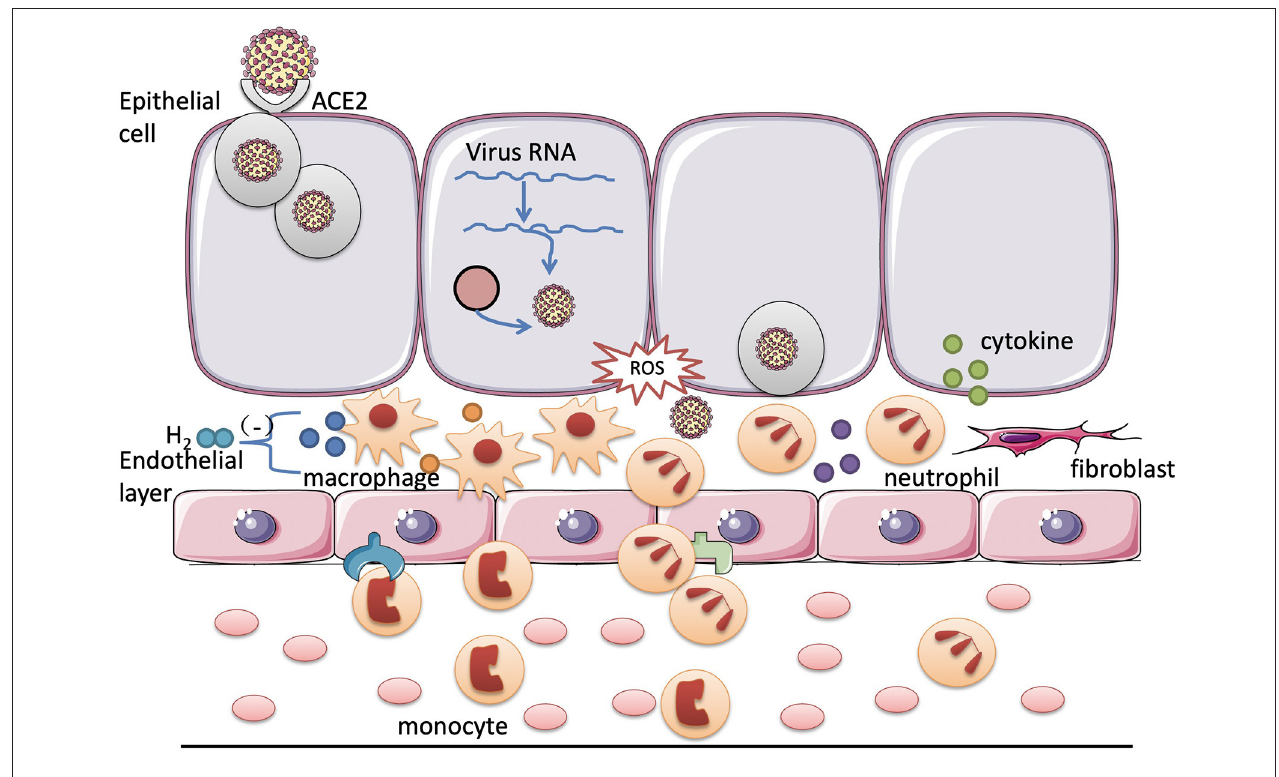
FIGURE 1 | Potential targets of hydrogen for the treatment of the coronavirus disease 2019 (COVID-19). After the viral infection, the inflammatory cells in the tissues and blood are activated to destroy the virus through phagocytosis and the release of cytokines. However, excessive inflammation causes uncontrollable body damage. In the COVID-19, hydrogen may exert its protective effect on the respiratory system by inhibiting the excessive activation of the neutrophils and macrophages and reducing the release of the cytokines.